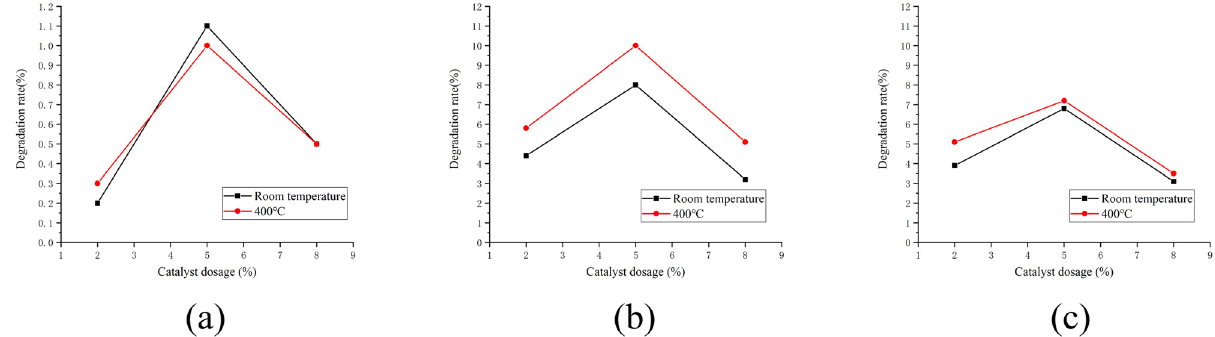
Figure 8: Comparison of photocatalytic performance of catalysts treated at di ff erent temperatures under visible light sources. ( a ) TiO 2 concrete, ( b ) CdS/TiO 2 - R400 concrete, ( c ) CdS/TiO 2 - R600